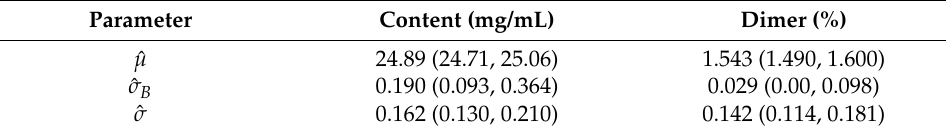
Table 2. Different parameters estimated by the maximum likelihood method and their corresponding 95% confidence intervals (in brackets) calculated using Equation